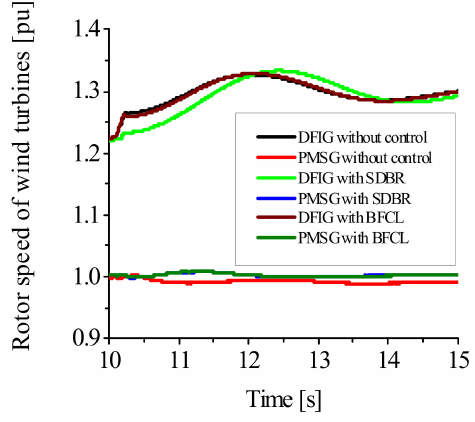
Figure 18. Rotor speed of the wind turbines.